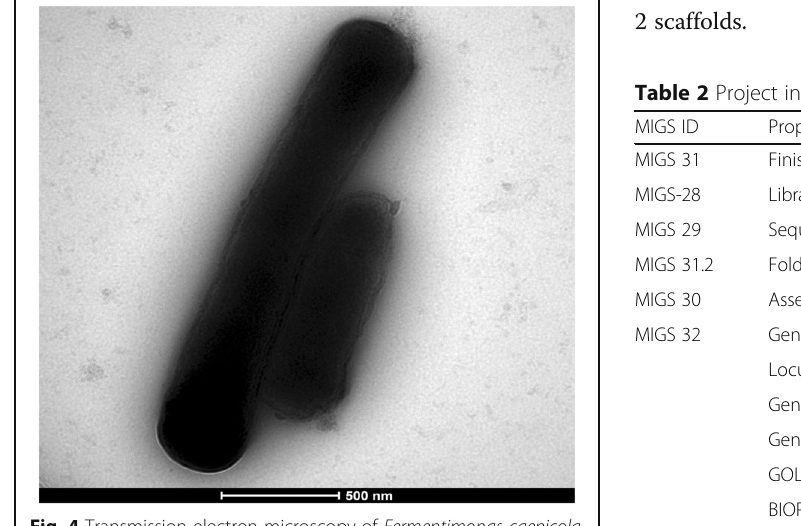
Fig. 4 Transmission electron microscopy of Fermentimonas caenicola strain SIT8 using a Morgani 268D microscope (Philips, Amsterdam, The Netherlands) at an operating voltage of 60 kV. Scale bar=500 nm